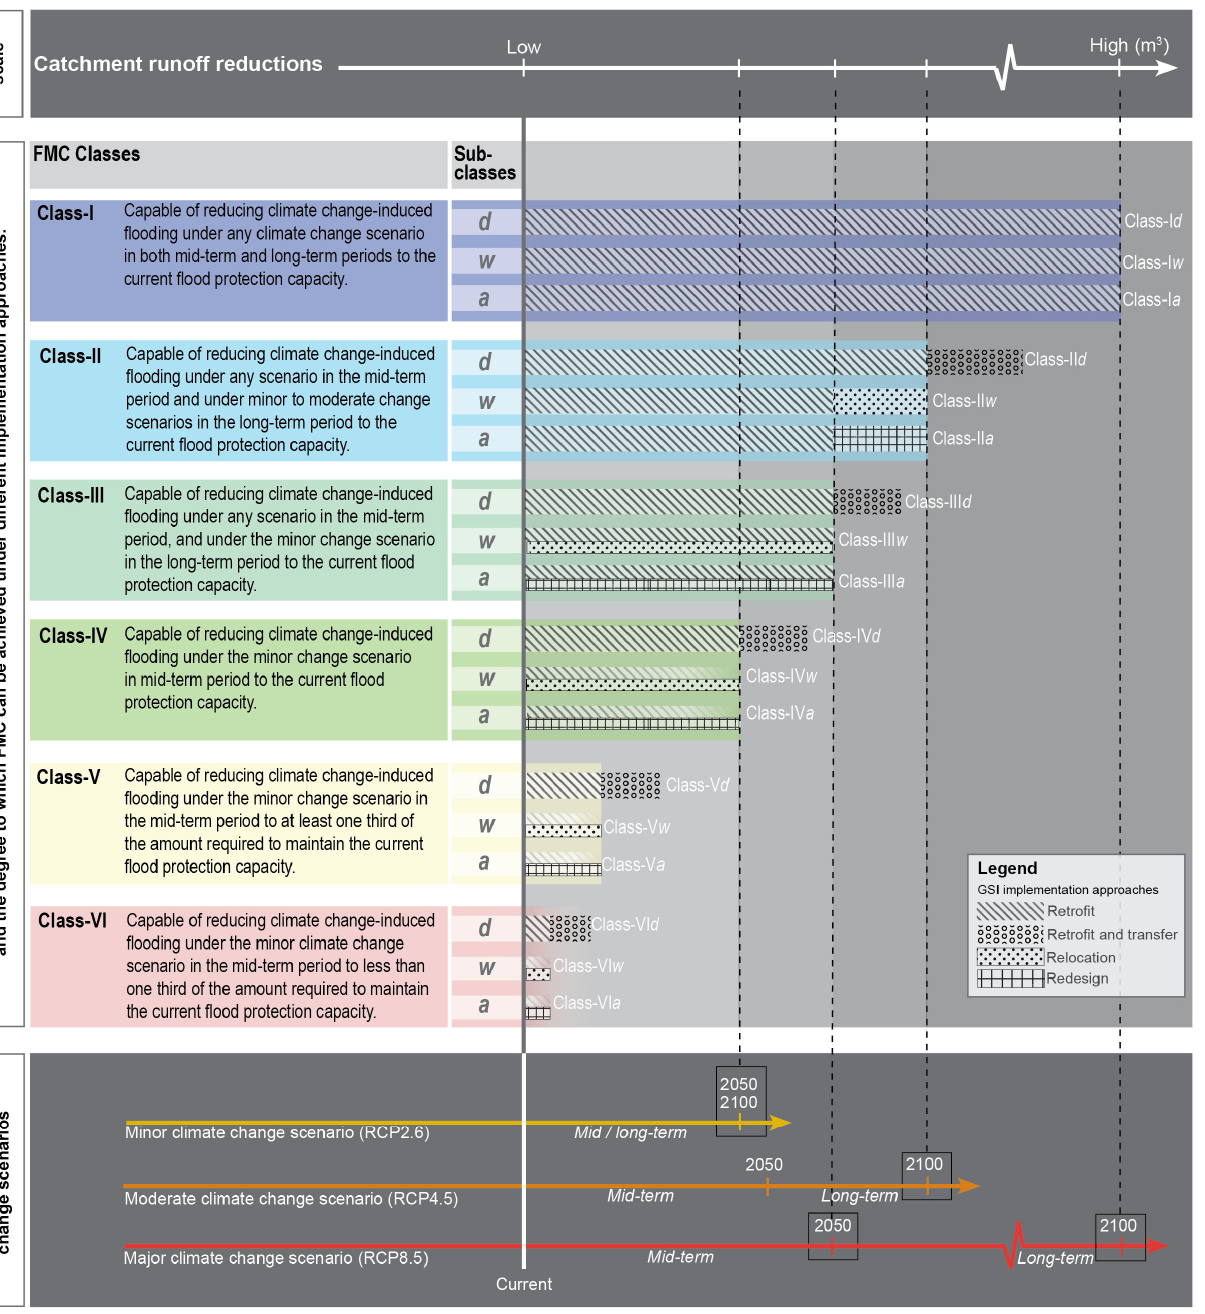
zone. This is referred to as a retrofit and transfer approach to implementation.